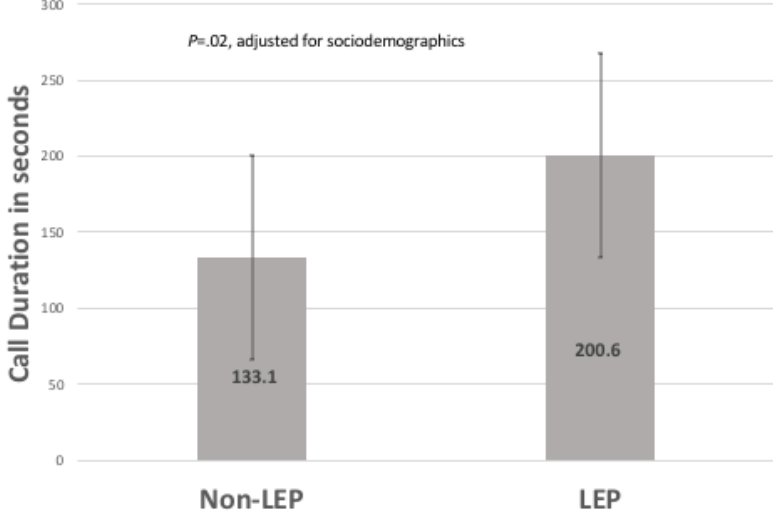
Figure 1. Mean (SD) of automated telephone self-management call duration by English proficiency. LEP: limited English proficiency.